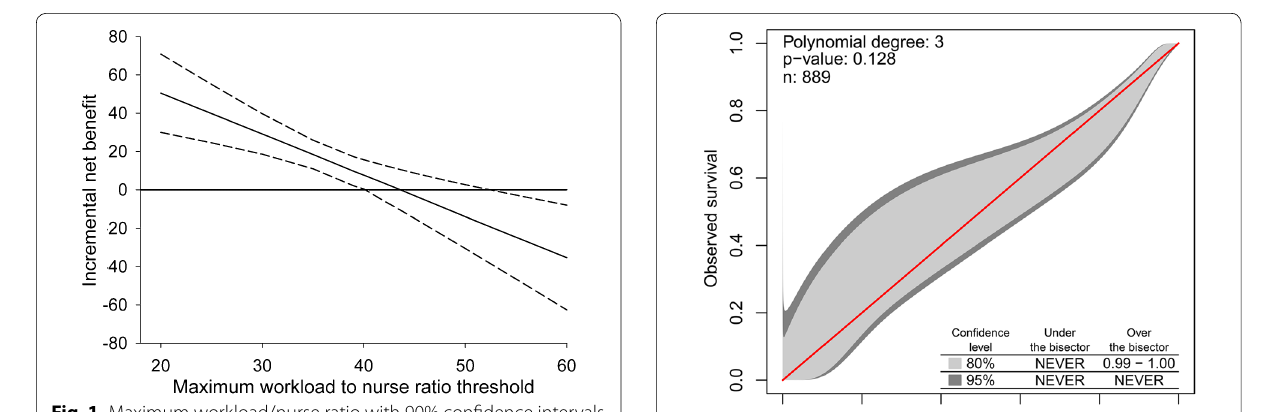
Fig. 1 Maximum workload/nurse ratio with 90% confidence intervals